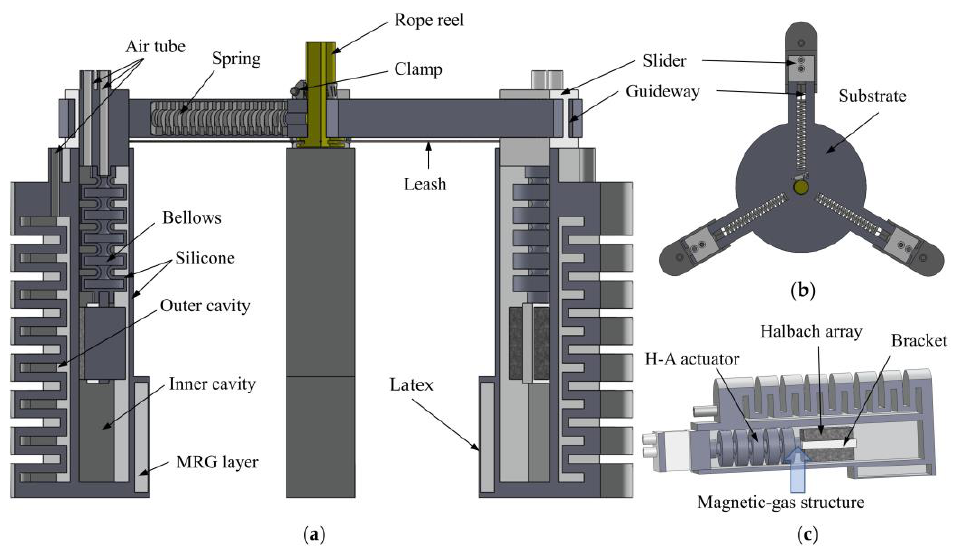
Figure 1. Three − dimensional rendering of the soft gripper. ( a ) Structure diagram of the overall soft robot; ( b ) Top view of soft finger fixture holder; ( c ) Internal cutaway view of the soft finger.